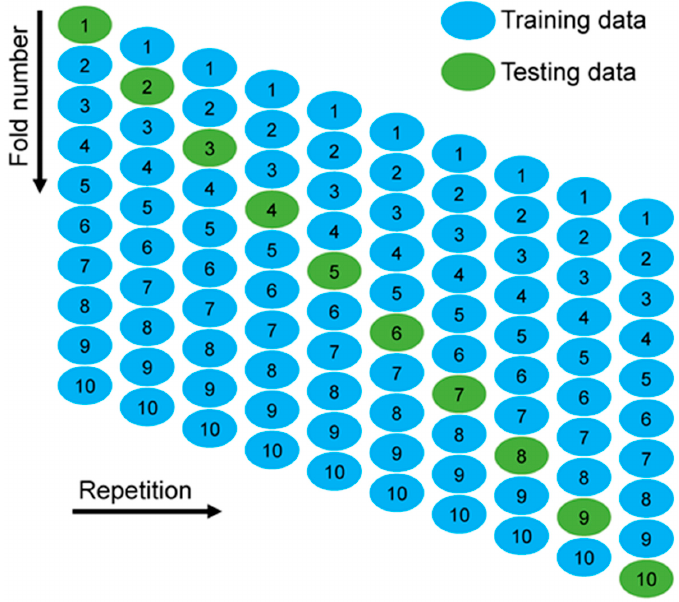
Figure 18. Statistical analysis of MLP model.